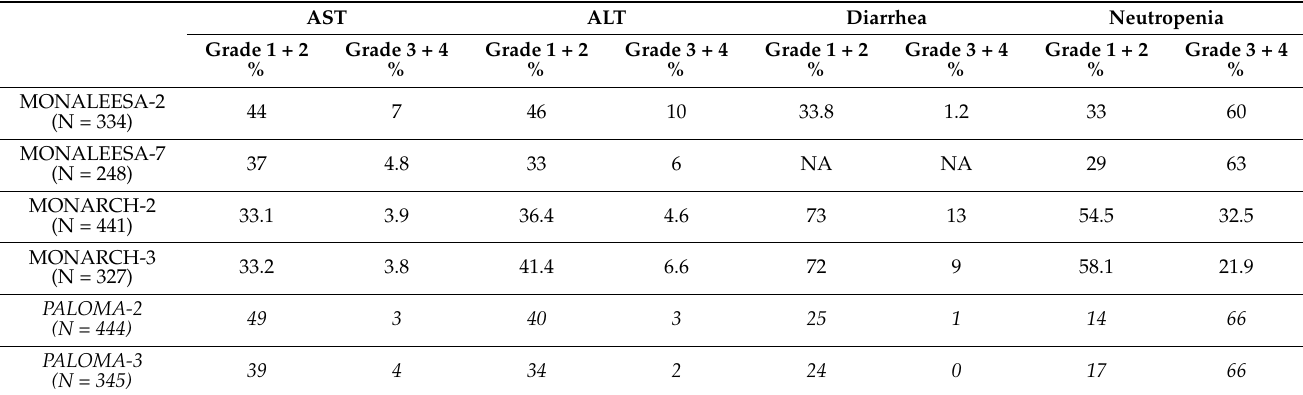
Table 5. Liver toxicity, diarrhea, and neutropenia occurrence in the three pivotal trials for CDK4/6